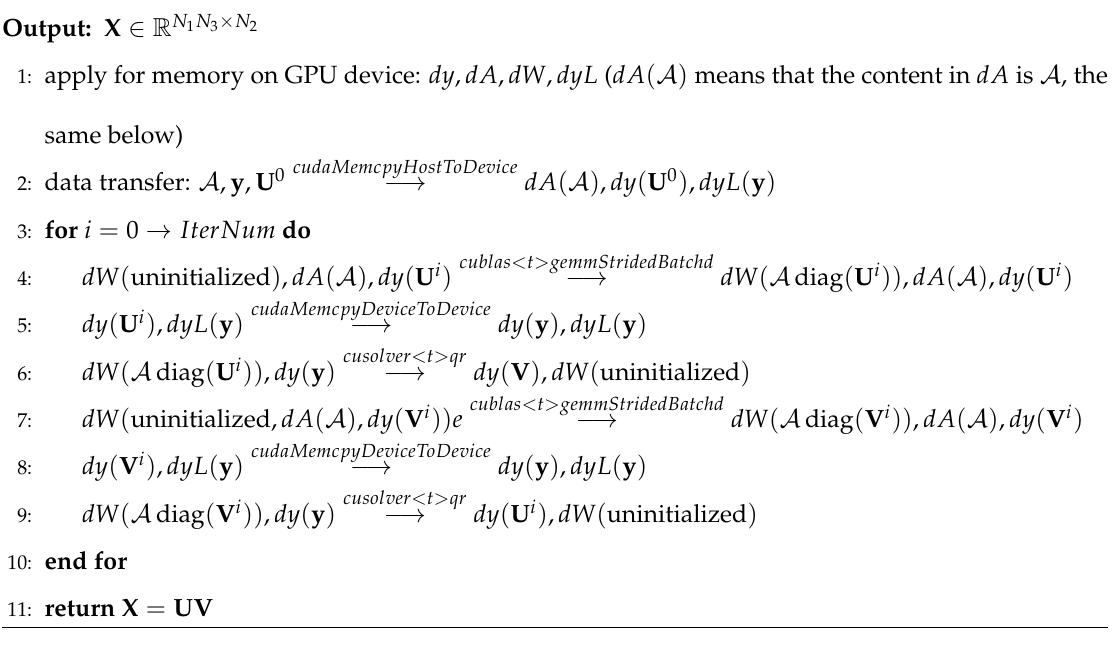
Algorithm 3 Computation flow of the tensor sensing on the